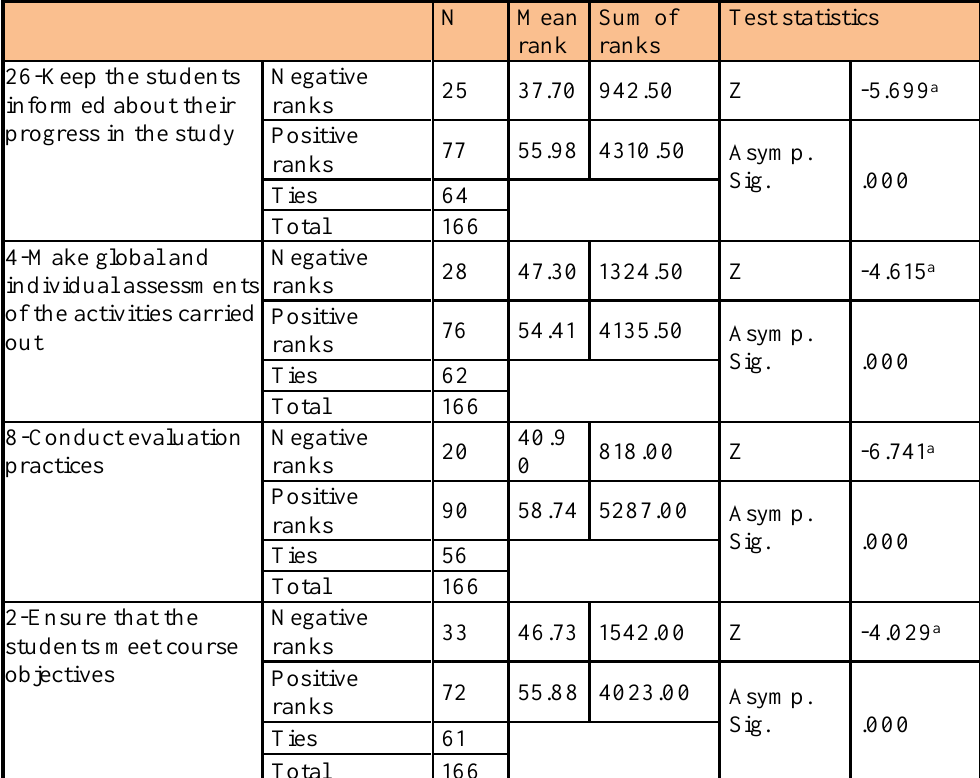
Wilcoxon Signed Ranks Test. Median Difference on the Level of Proficiency and Professional Development Needs Regarding the Evaluator Role Competencies Applied to Online